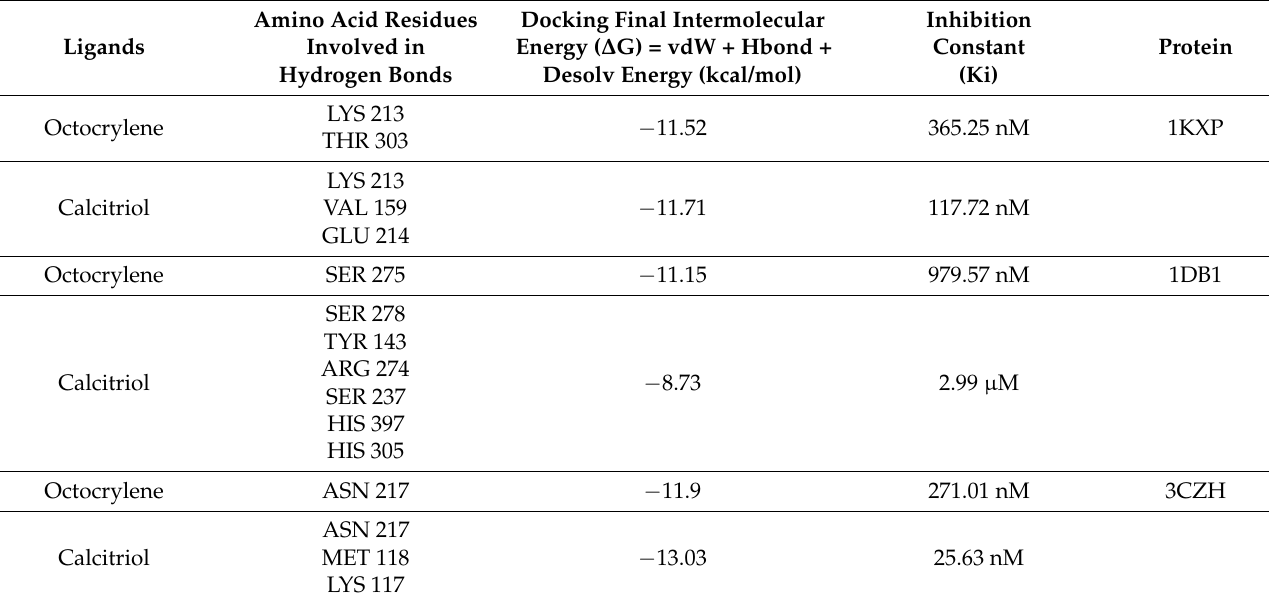
Figure 7. Calcitriol molecular interaction with the enzyme CYP2R1. Table 2. Molecular interaction